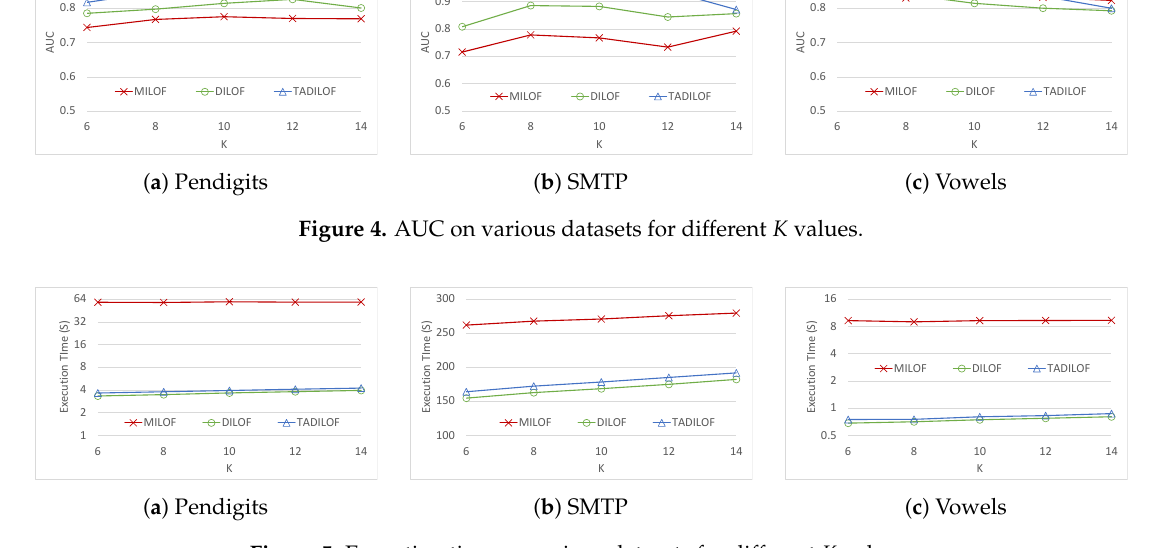
Figure 5. Execution time on various datasets for different K